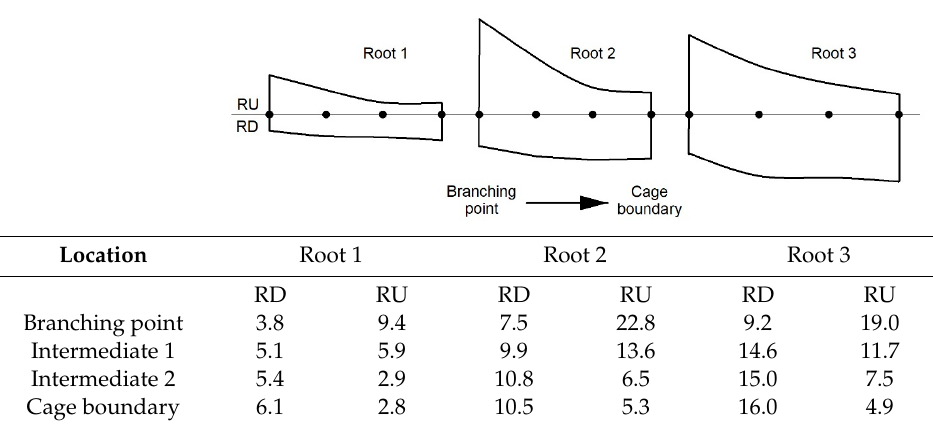
Table 1. A schematic of the eccentricity of three randomly selected roots and the actual radius lengths (cm). RD, radius length moving from the centroid (black dot in Figure 2) downward, away from the soil surface. RU, radius length moving from the centroid upward toward the soil surface. For each root, moving left to right is the branching point on the taproot to the cage boundary. The four dots from left to right represent, respectively, the position of the centroid: first dot on the left at the branching point; second dot from the left at 1/3 of the root length (intermediate 1), third dot from left at 2/3 of the root length (intermediate 2), fourth dot from the left at the edge boundary.